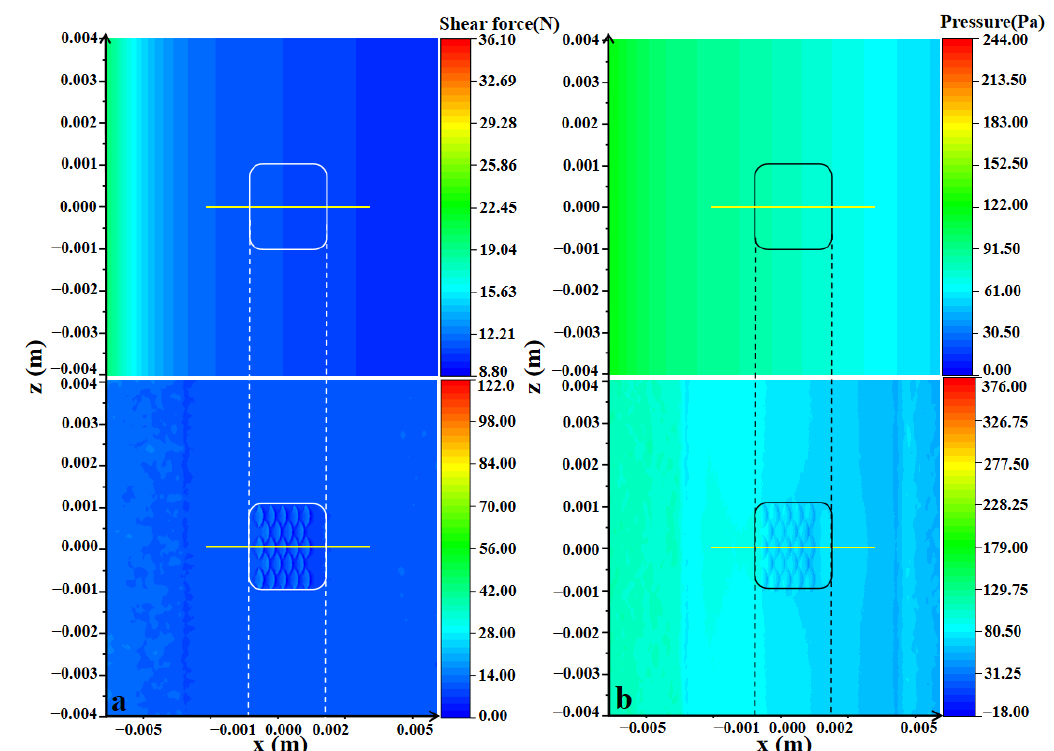
Figure 15. Shear force and pressure contour of the upper and lower surfaces. ( a ) Shear force contour; ( b ) Pressure contour.